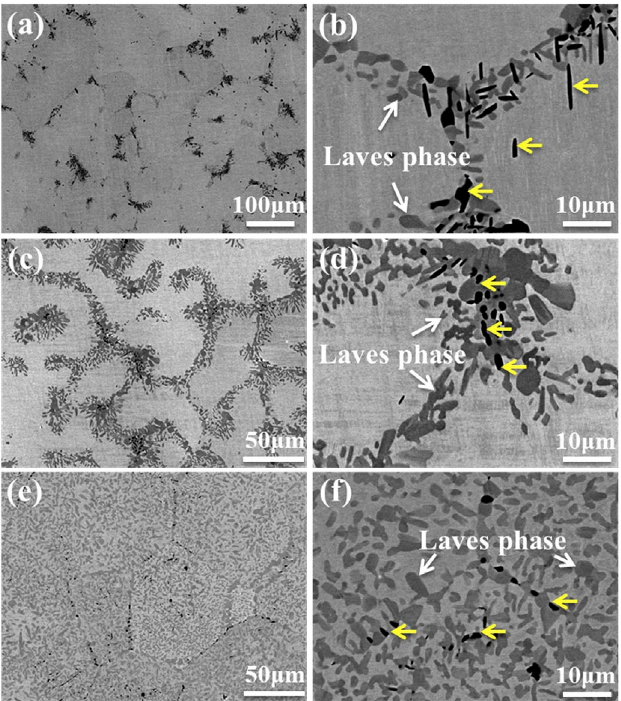
Figure 3. SEM backscatter electron images of the annealed ( a , b ) Cr1.0, ( c , d ) Cr1.5 and ( e , f ) Cr2.0 alloys. Reprinted with permission from Ref. [26]. Copyright 2020 Elsevier. alloys. Reprinted with permission from Ref. [26]. Copyright 2020